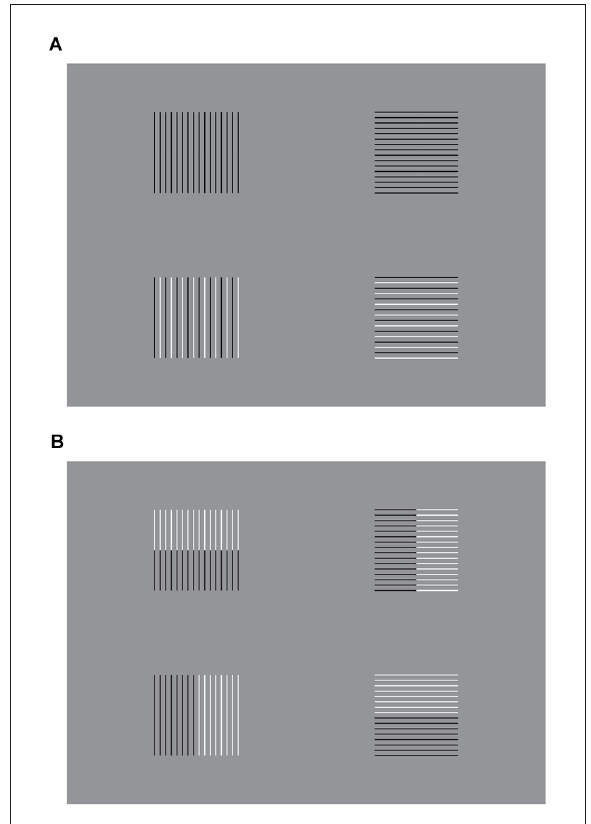
FIGURE4 (A) Two examples of Helmholtz’s square illusion showing the widening of the square made up of vertical line segments and its lengthening when the lines are placed horizontally. (B) The size effect of Helmholtz’s squares can be strengthened (first row) or weakened (second row) by pitting the sources of directional organization, imparted by the similarity, in favor or against the disposition of